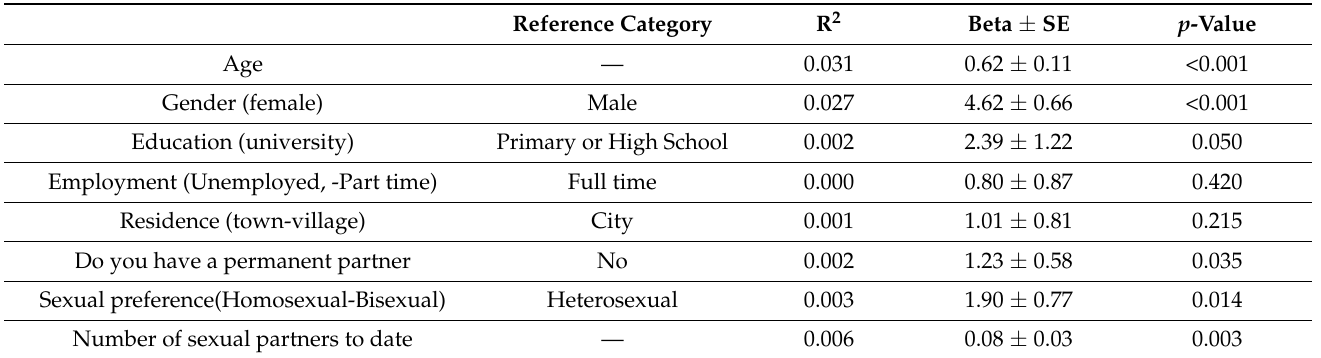
Table 6. Multifactorial analysis of STD knowledge score in relation to demographic characteristics. Reference